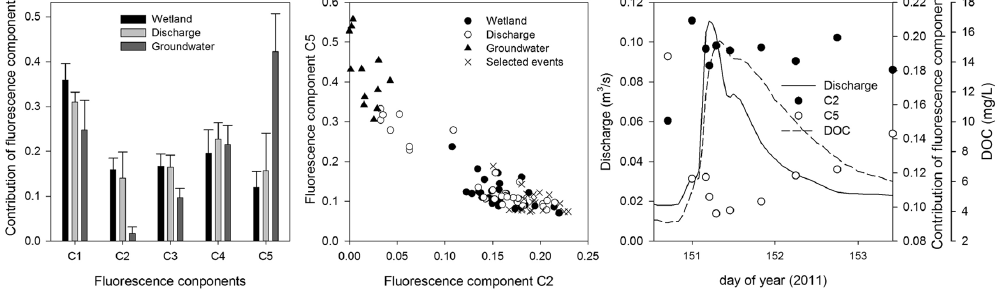
Fig. 4. Left: contributions of the 5 identified fluorescence components (PARAFAC Model after Stedmon and Bro, 2008) to the samples from the compartments “shallow wetland groundwater” (Wetlands) and “deep groundwater” (Groundwater) and in the stream water (Discharge). Middle: meparation of the DOC sources by use of the two fluorescence components C2 (characterising wetland DOC quality) and C5 (characterising groundwater DOC quality). Those of the discharge samples (open circles) resembling groundwater samples (solid triangles) were all sampled upstream close to a groundwater seepage area with little impact by wetland soils. Samples from the two selected discharge events (see results section) are depicted as X. Right: contribution of fluorescence components C2 and C5 to total DOC fluorescence during the discharge event from 31 May 2011 (dry preconditions), discharge hydrograph, and DOC concentrations over